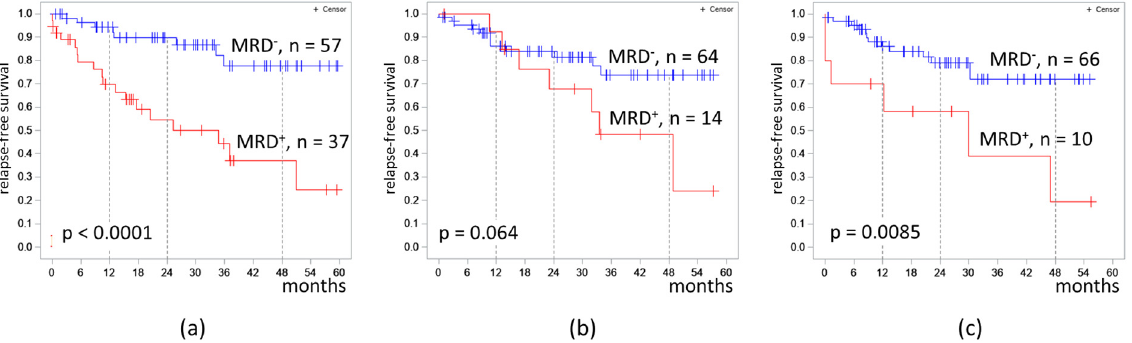
Figure 3. Relapse-free survival of patients with B-cell acute lymphoblastic leukemia depending on MRD at different timepoints: ( a ) at the end of induction II (day 70); ( b ) at the end of consolidation III (day 133); ( c ) at the end of consolidation V (day 190). The initial date was the date of